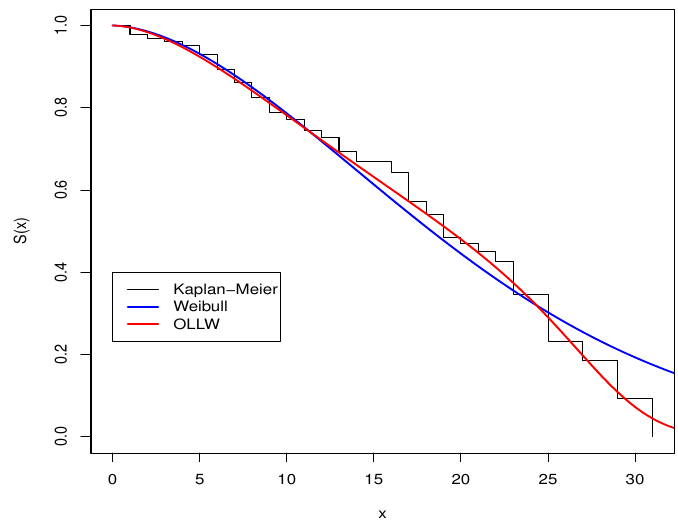
Figure 6. The estimated and empirical survival functions for COVID-19